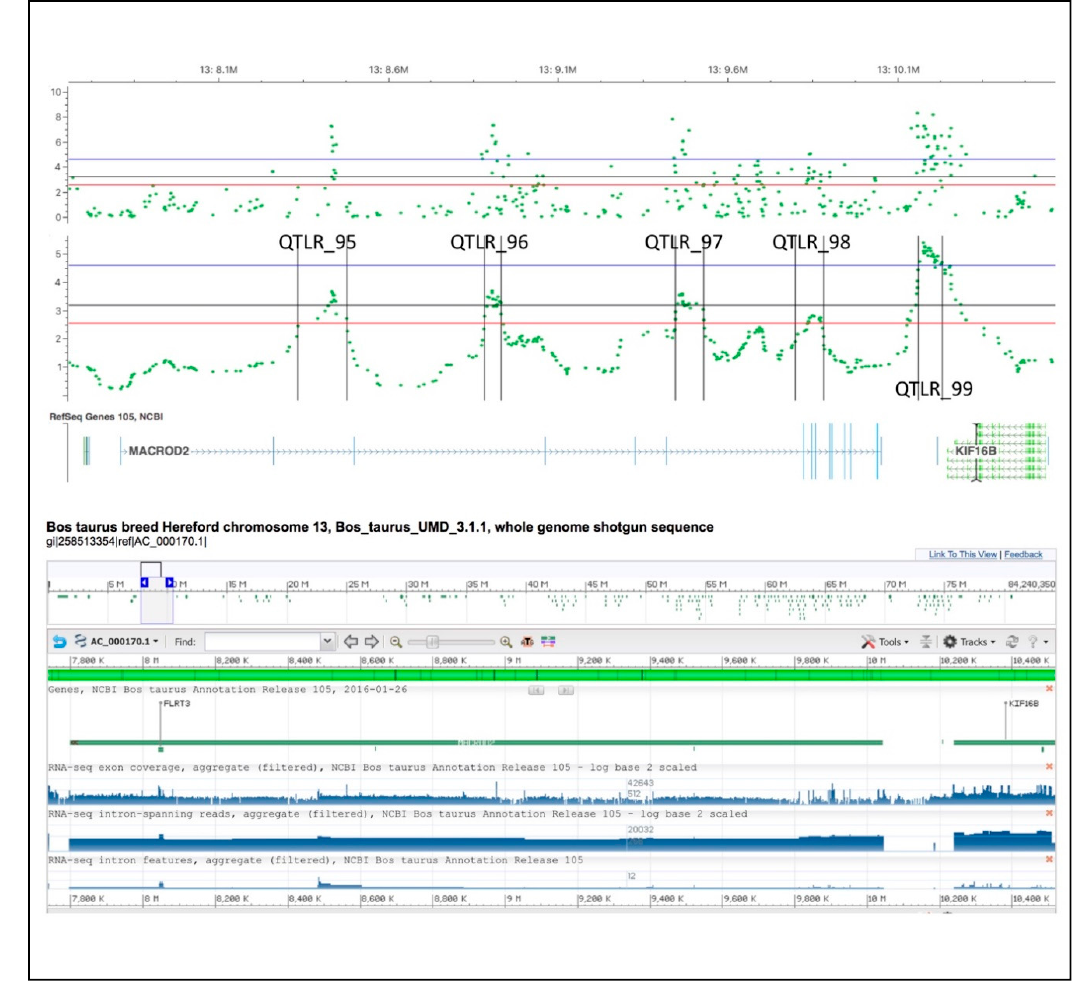
Figure 4. The location of MACROD2 gene is spread over the QTLRs 95–98 (NCBI refseq gene 105).